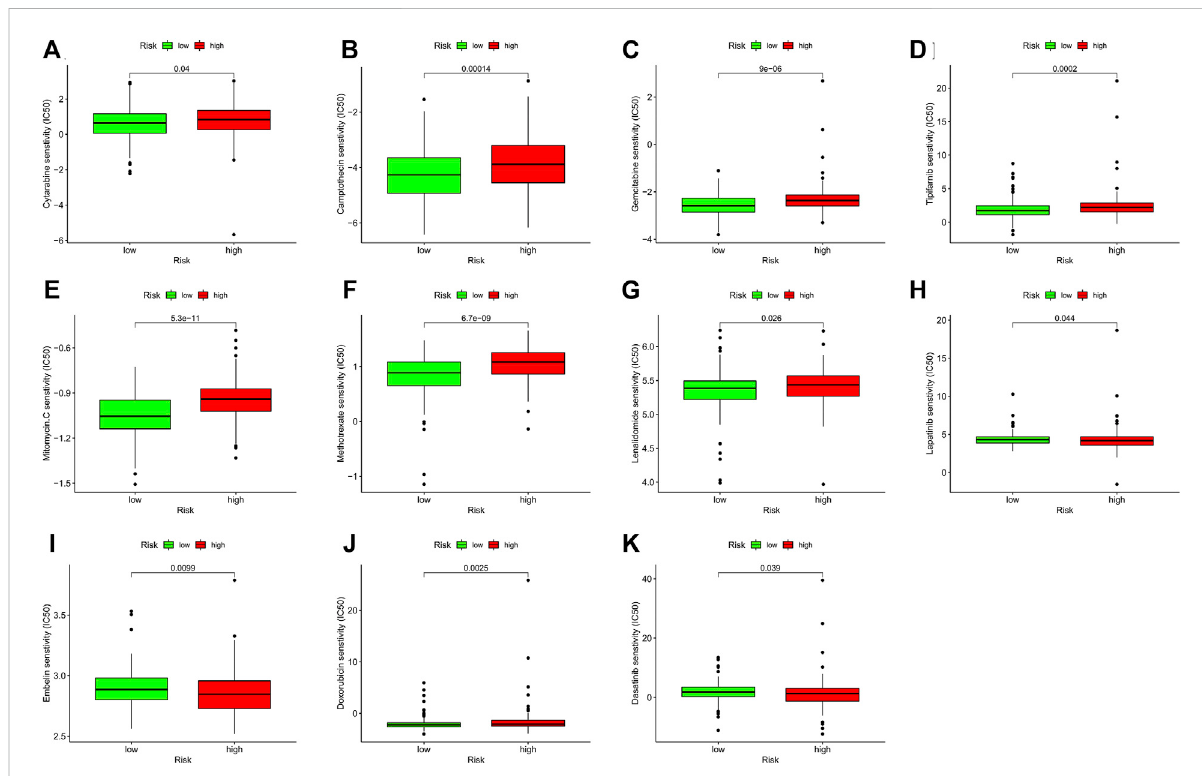
FIGURE 7 ThecorrelationanalysisofthesensitivityofchemotherapeuticagentswithGCpatients ’ riskscore. (A – K) Representedelevenchemotherapeutic agents ’ IC50 in different risk groups. The green and red boxes represent low-GC risk and high-GC risk group, respectively. GC, gastric cancer.